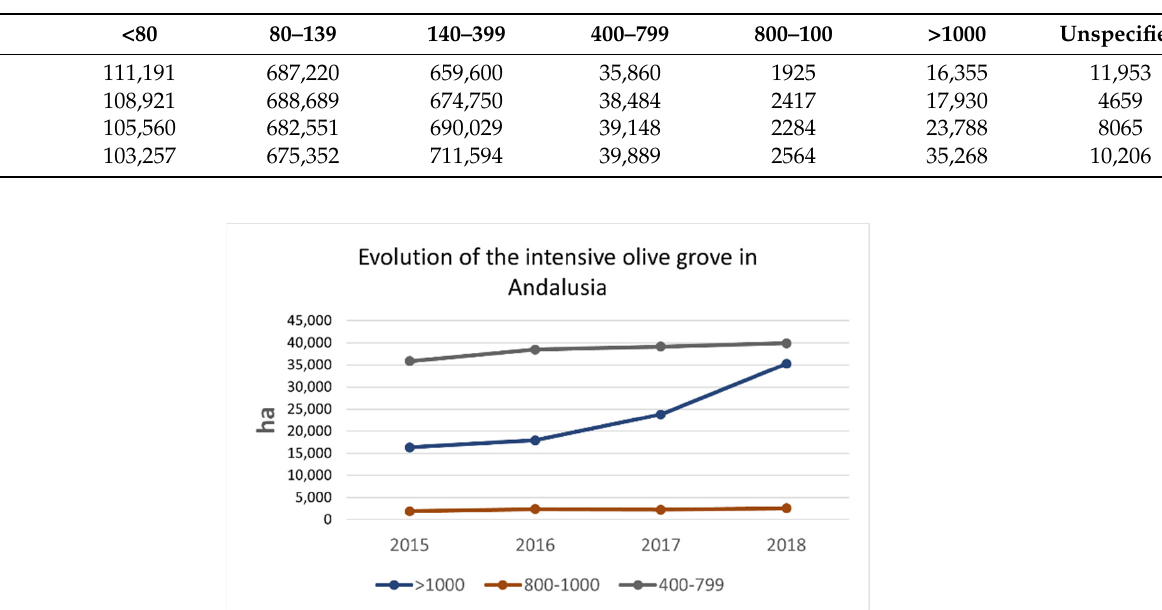
Table 1. Olive grove area (ha) per year and plantation density (trees/ha). Source: Analysis of the density in olive plantations in Andalusia. Regional Ministry of Agriculture, Livestock and Fisheries.